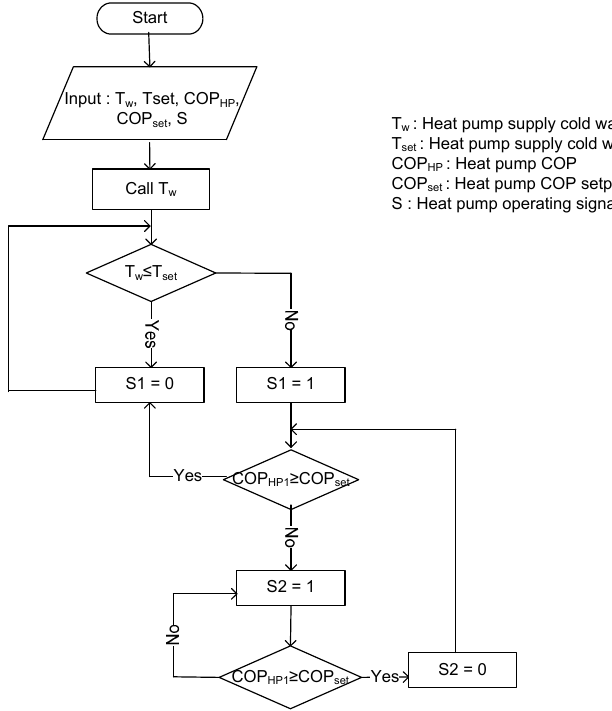
Figure 6. Sequential control method algorithm by the COP.